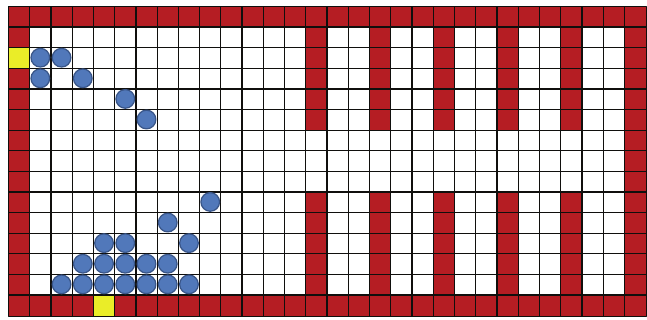
Figure 9: Snapshot of a simulation for the room in Figure 8 after 35 time